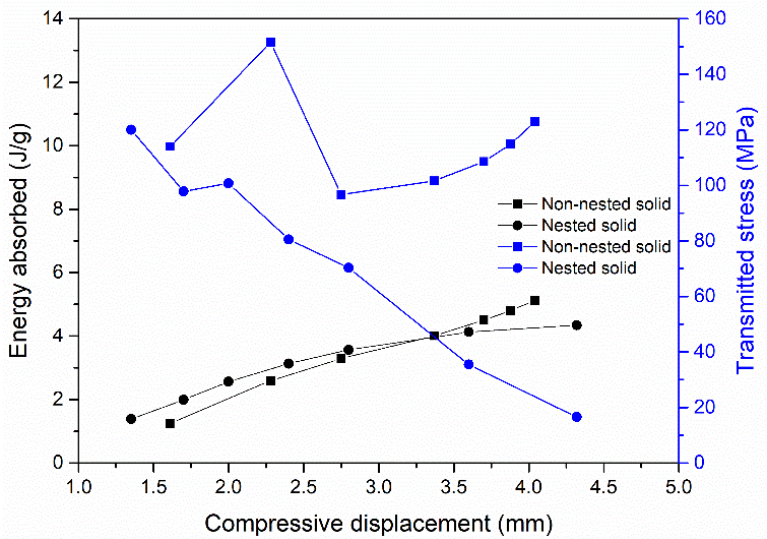
Figure 5. Variation of energy absorbed (J/g) and transmitted stress (MPa) with compressive displacement during the compression of nested cellular solid; and non-nested cellular solid.